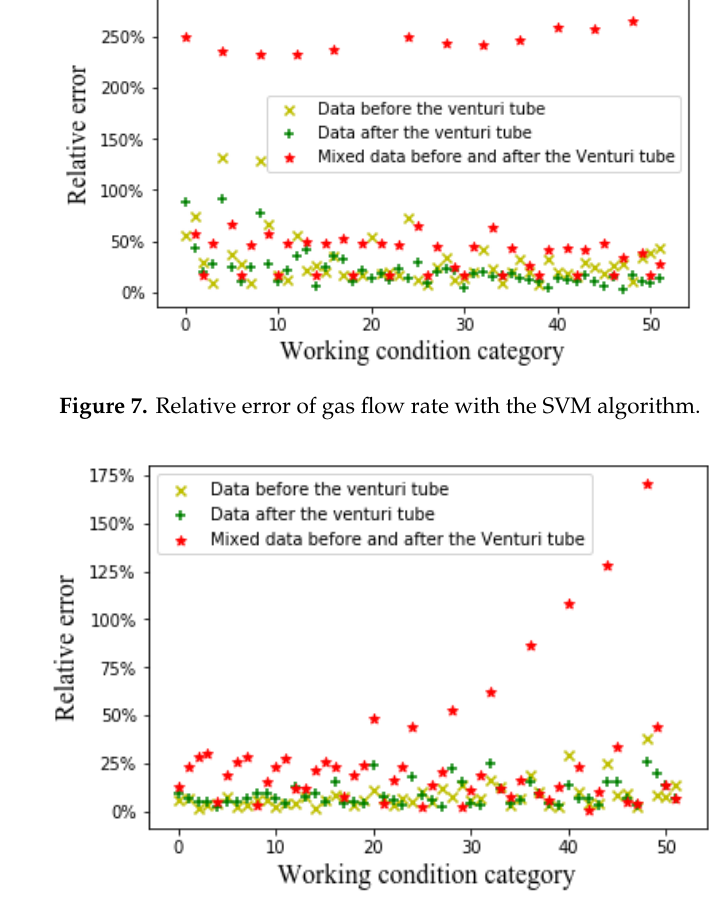
Figure 8. Relative error of GVF with SVM algorithm.